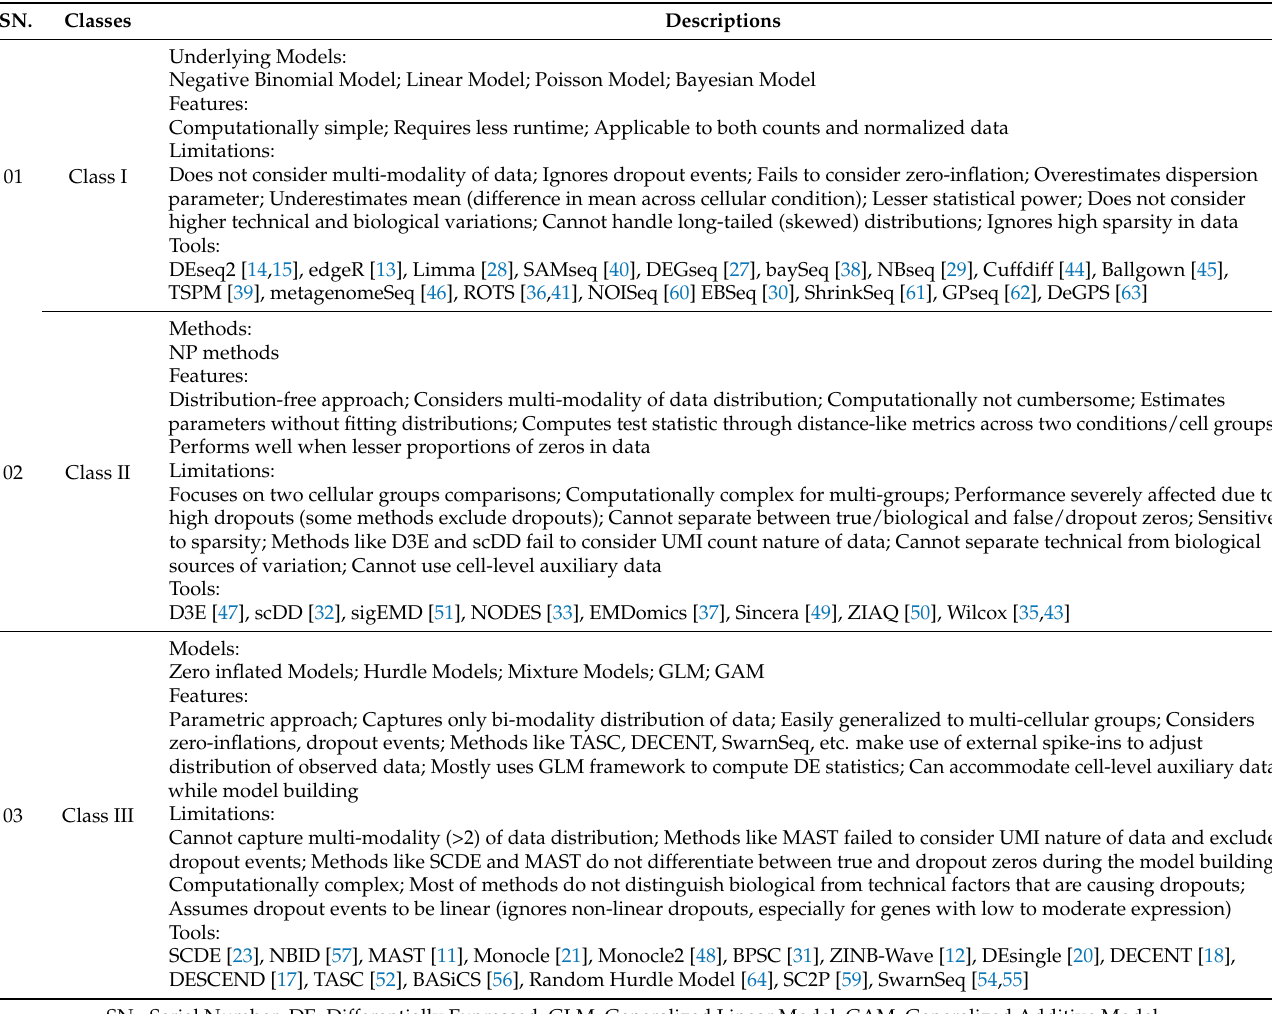
Table 2. Classification of methods used for detection of DE genes in scRNA-seq